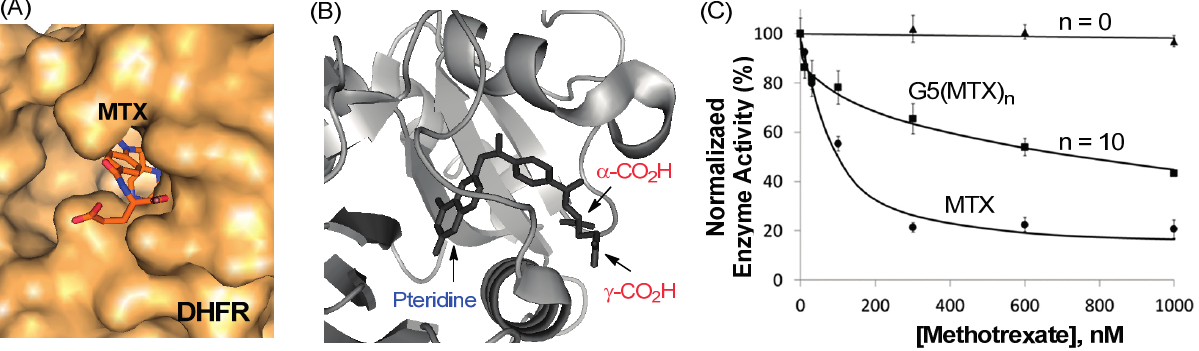
Figure 5. ( A , B ) A crystal structure of a MTX molecule in complex with dihydrofolate reductase (DHFR) at its catalytic site (PDB code 1DDS [80], 1U72 [81]). The protein (surface, cartoon) and MTX molecule (stick) model of the enzyme-drug complex was generated by PyMOL™ (version 1.3); ( C ) Inhibition of human DHFR enzyme activity by MTX and G5(MTX) n ( n = 0, 10; Figure 3) conducted in a standard enzyme assay [52]. The